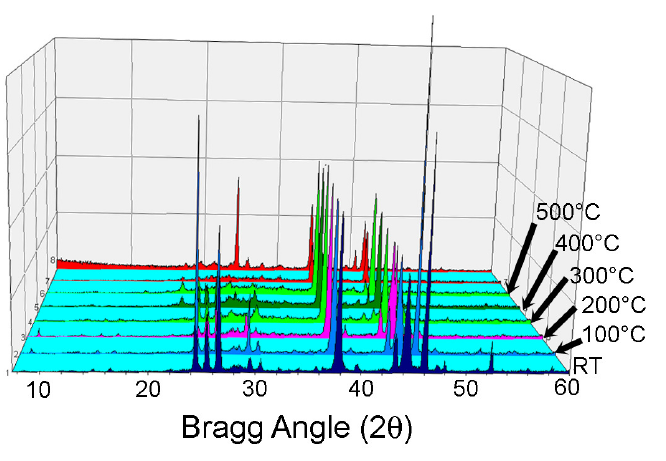
Figure 1. Temperature dependent in-situ powder X-ray diffraction patterns for type-I clathrate Ba Ga Sn . The peak at ca. 39° 2 θ that does not change with T is from the 8 14.5 31.5(4) Pt